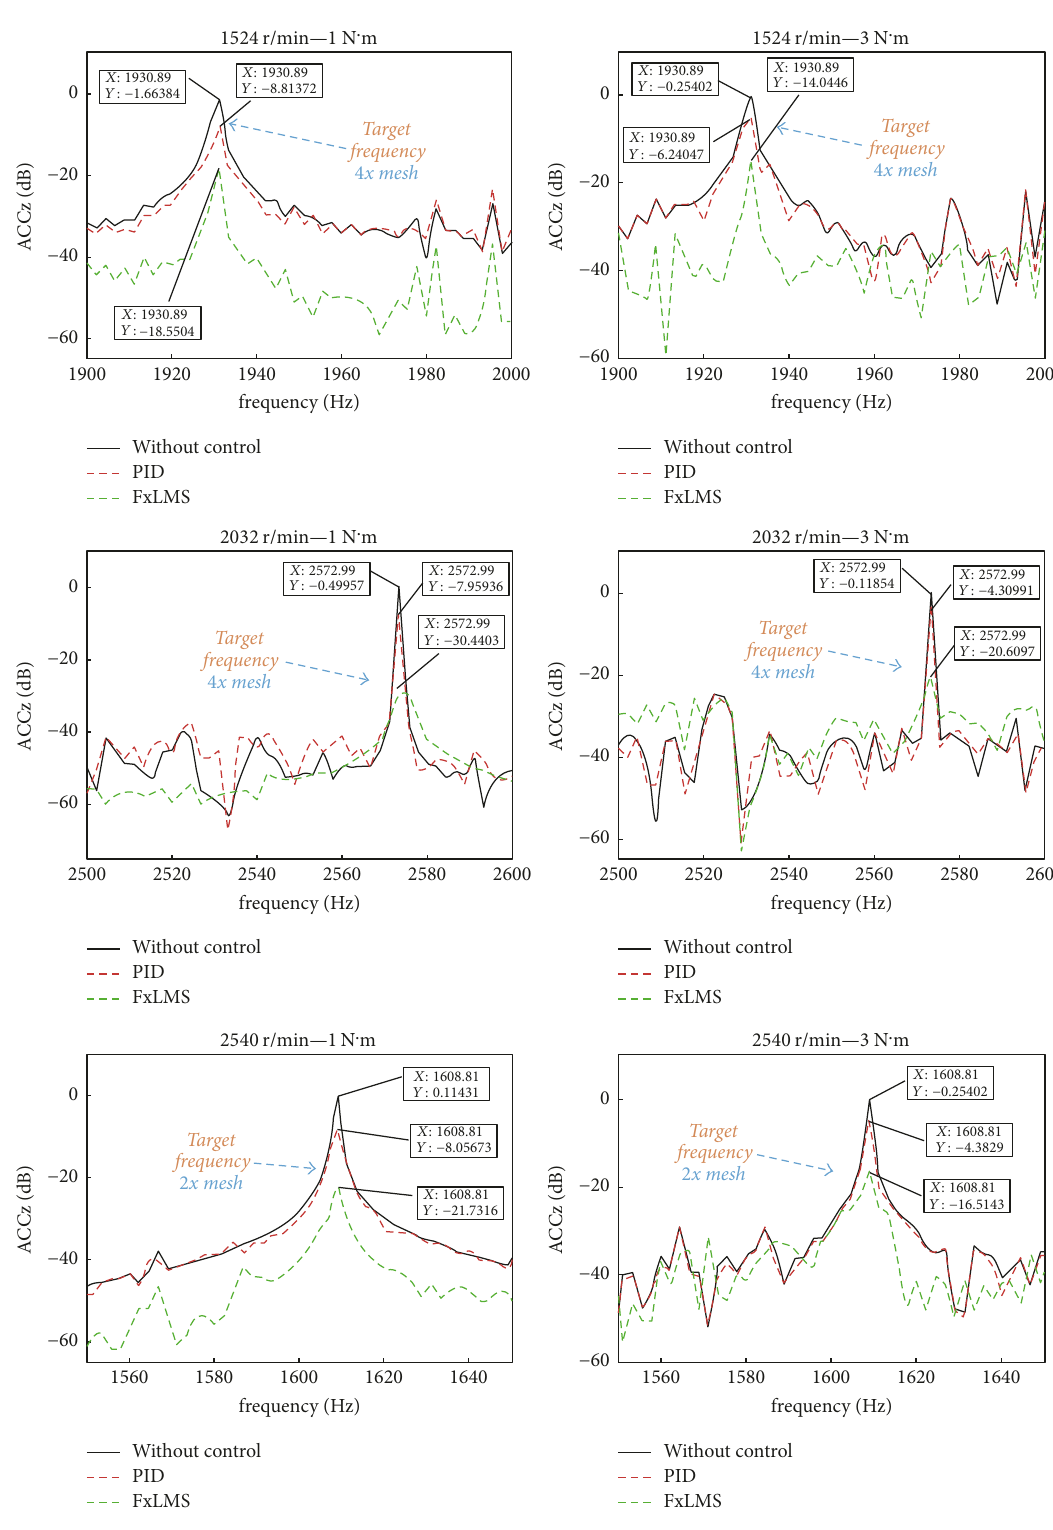
Figure 10: The vibration control results of the input shaft at the gear rotation